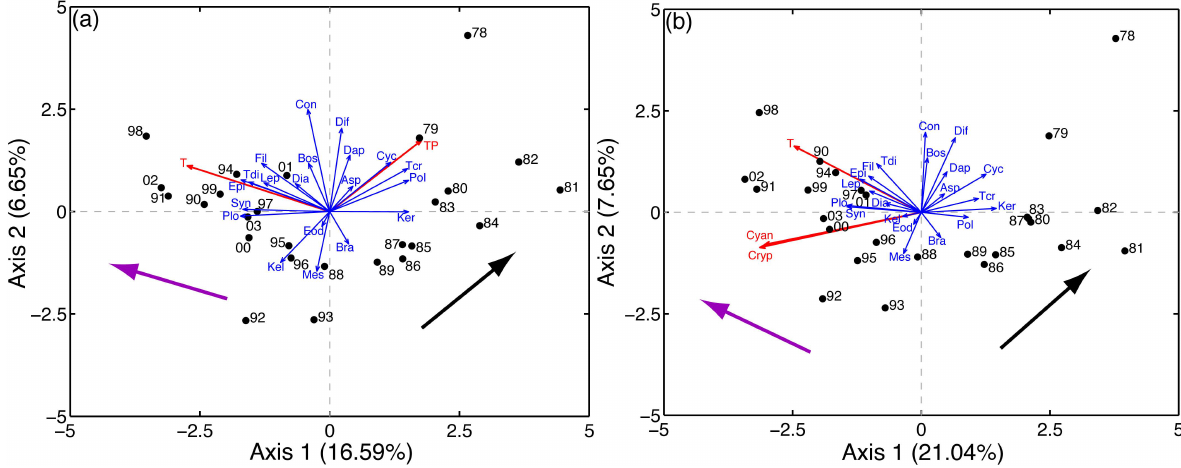
Fig. 6. Biplot of redundancy analysis relating years (1978 to 2003) and zooplankton taxa and depicting (a) how temperature and TP, and (b) how temperature, biomasses of Cryptophyceae and Cyanobacteria affected zooplankton dynamics. The black arrow indicates a gradient of increased eutrophic status, and the purple arrow indicates a warming